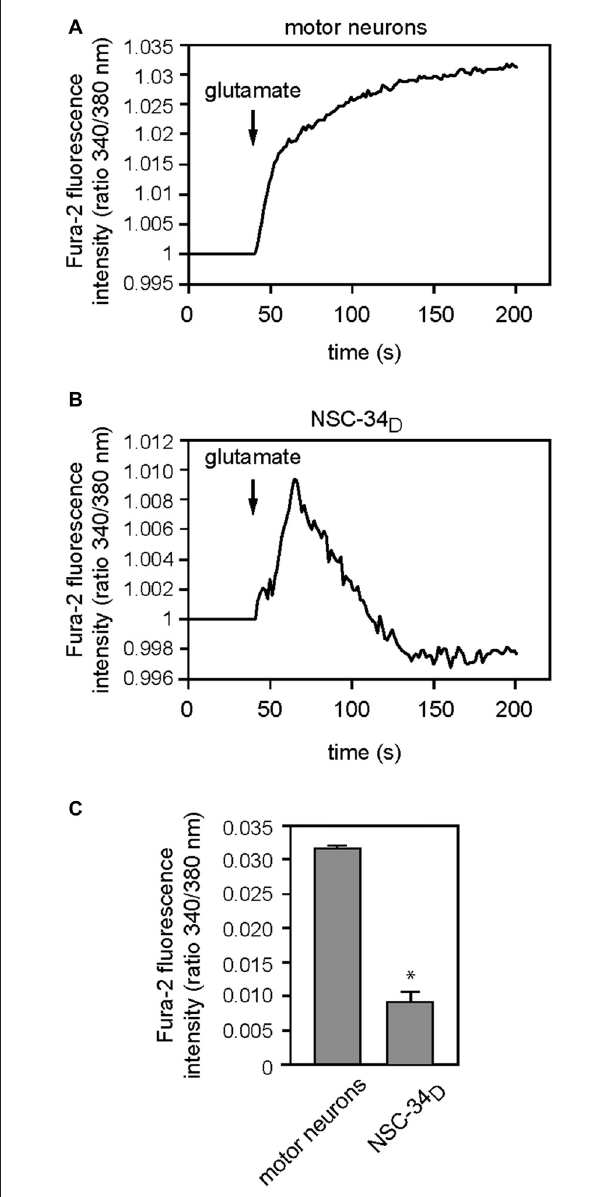
FIGURE 4 | Acute effects of 100 mM and 1 mM glutamate (for primary MN and NSC-34 D , respectively) for 200 s on calcium entry . Representative fluorescence measurement of Ca 2 + entry in MN (A) and NSC-34 D (B) after acute application of glutamate. Glutamate was added at the time indicated by the arrow. (A) Mean traces of cytosolic Ca 2 + flux of MN and (B) NSC-34 D in response to glutamate. (C) Histograms showing maximum fluorescence intensity following glutamate application in MN and NSC-34 D . Mean data ± SEM from three coverslips per cell type with at least five cells per coverslip analyzed. ∗ p < 0.001 (Mann-Whitney test MN vs. NSC-34 D